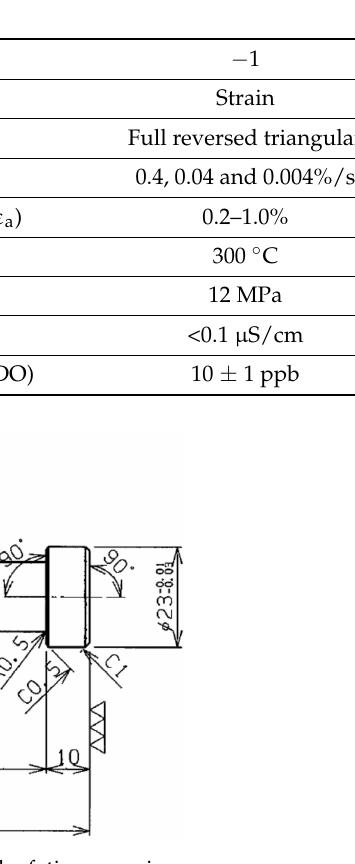
Figure 3. Schematic diagram showing the dimensions of the fatigue